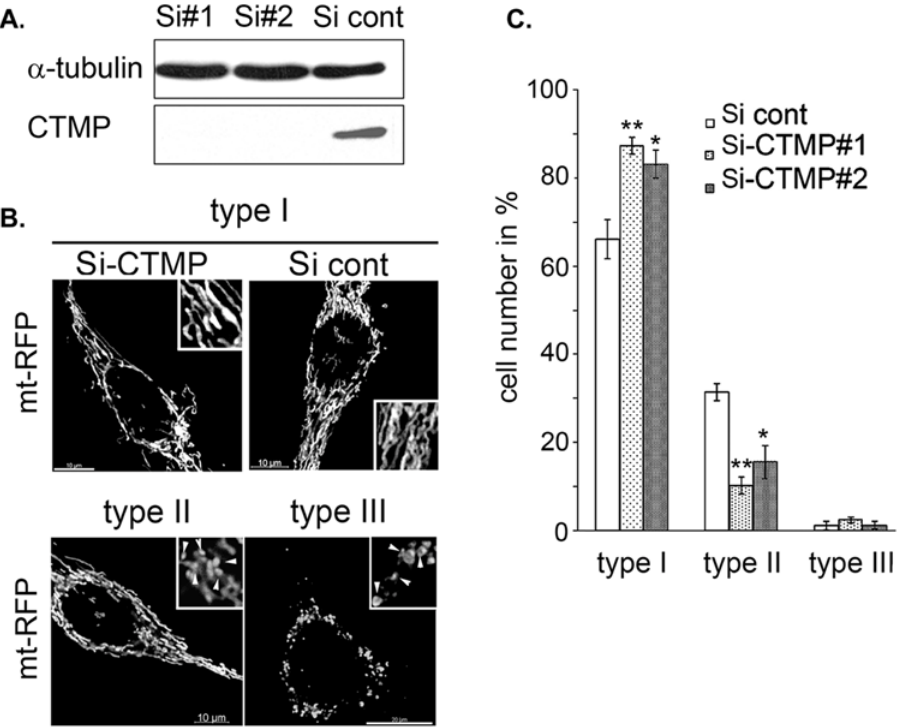
Figure 2. Loss of CTMP affects mitochondria morphology. (A) Immunoblot detection of CTMP using 75 m g of protein lysates extracted from Hela cells 48 h after transfection with control SiRNA (cont) or CTMP SiRNA # 1 or # 2. (B) Representative confocal picture of mitochondria shape in HeLa cells expressing mt-RFP and treated as in (A). (C) Morphological analysis of mitochondria shape in HeLa cells treated as in (A). For each experiment, at least 200 cells were counted in three distinct fields. Data are means 6 SEM, n =2. The differences in mean values are statistically significant (Si cont compared to Si-CTMP # 1 and Si-CTMP # 2) as determined by 1-way ANOVA; * P # 0.05, ** P # 0.001.